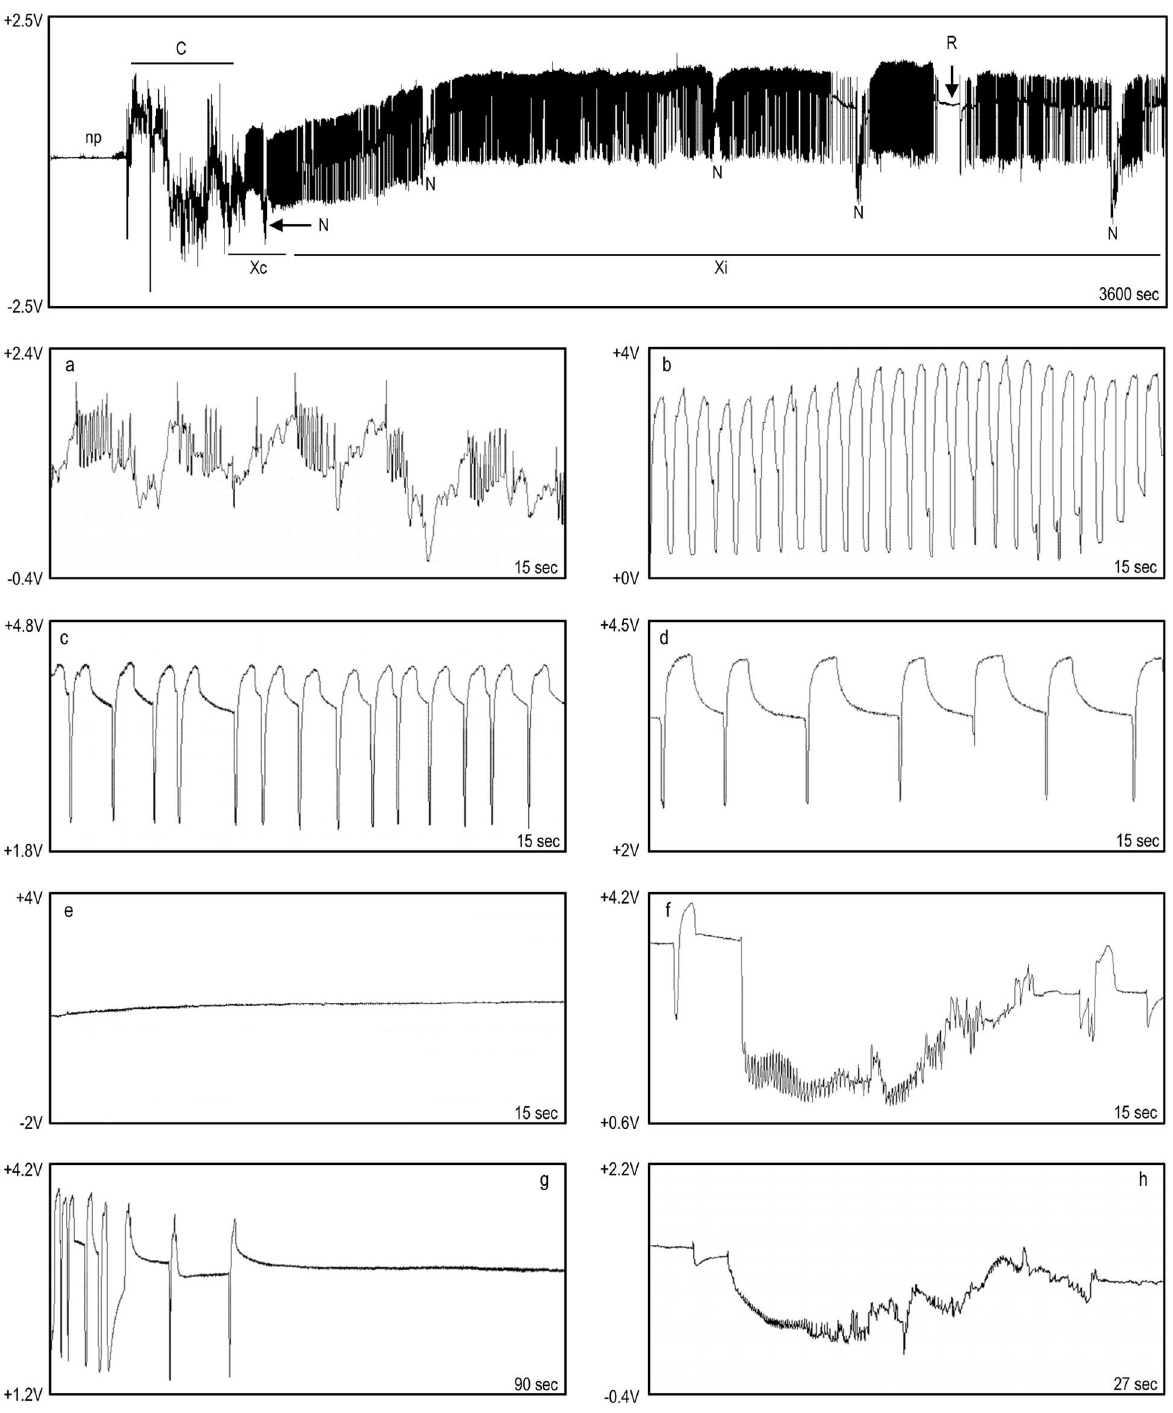
Fig 3. EPG recording for P . spumarius on olive. Non probing (np), waveform C followed by Xc and Xi, with N interspersed, and flat waveform R. Below the general view, close-ups of the waveforms: a) C; b) Xc; c) Xi, high frequency; d) Xi, low frequency; e) R; f) N; g) transition Xi/R; h) drop similar to N during